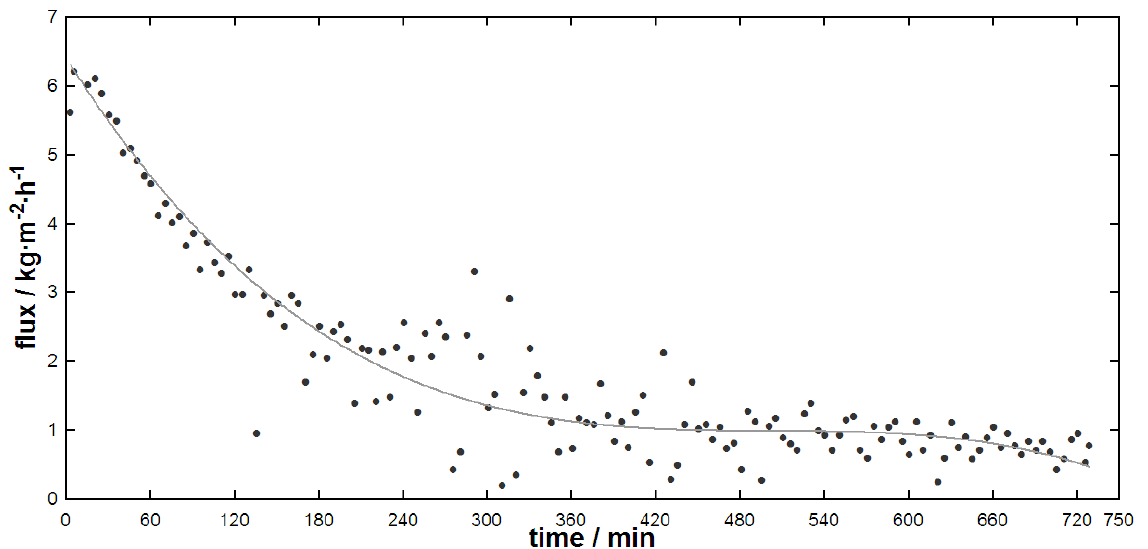
Figure 4. Flux during whole milk concentration by